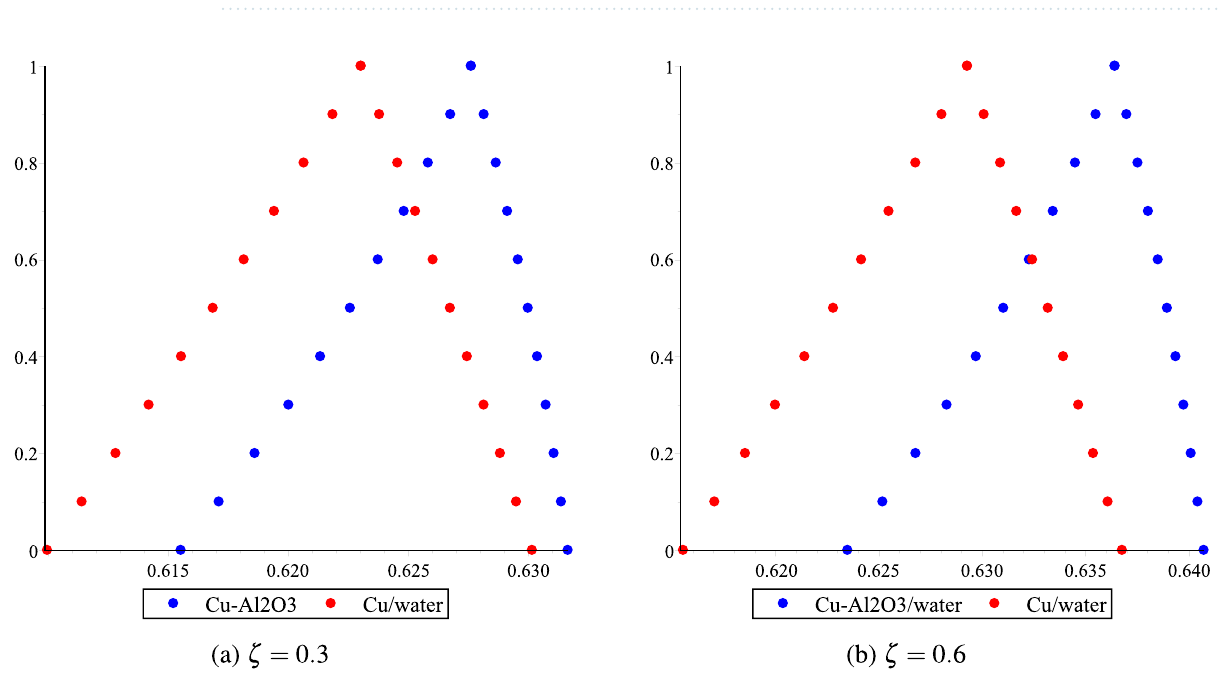
Figure 12. Effect of φ = [ 0%, 3%, 5% ] for Cu-H 2 O and Cu-Al 2 O 3 /H 2 O on fluid velocity distribution bound υ(α , δ , ζ) in ω < 0